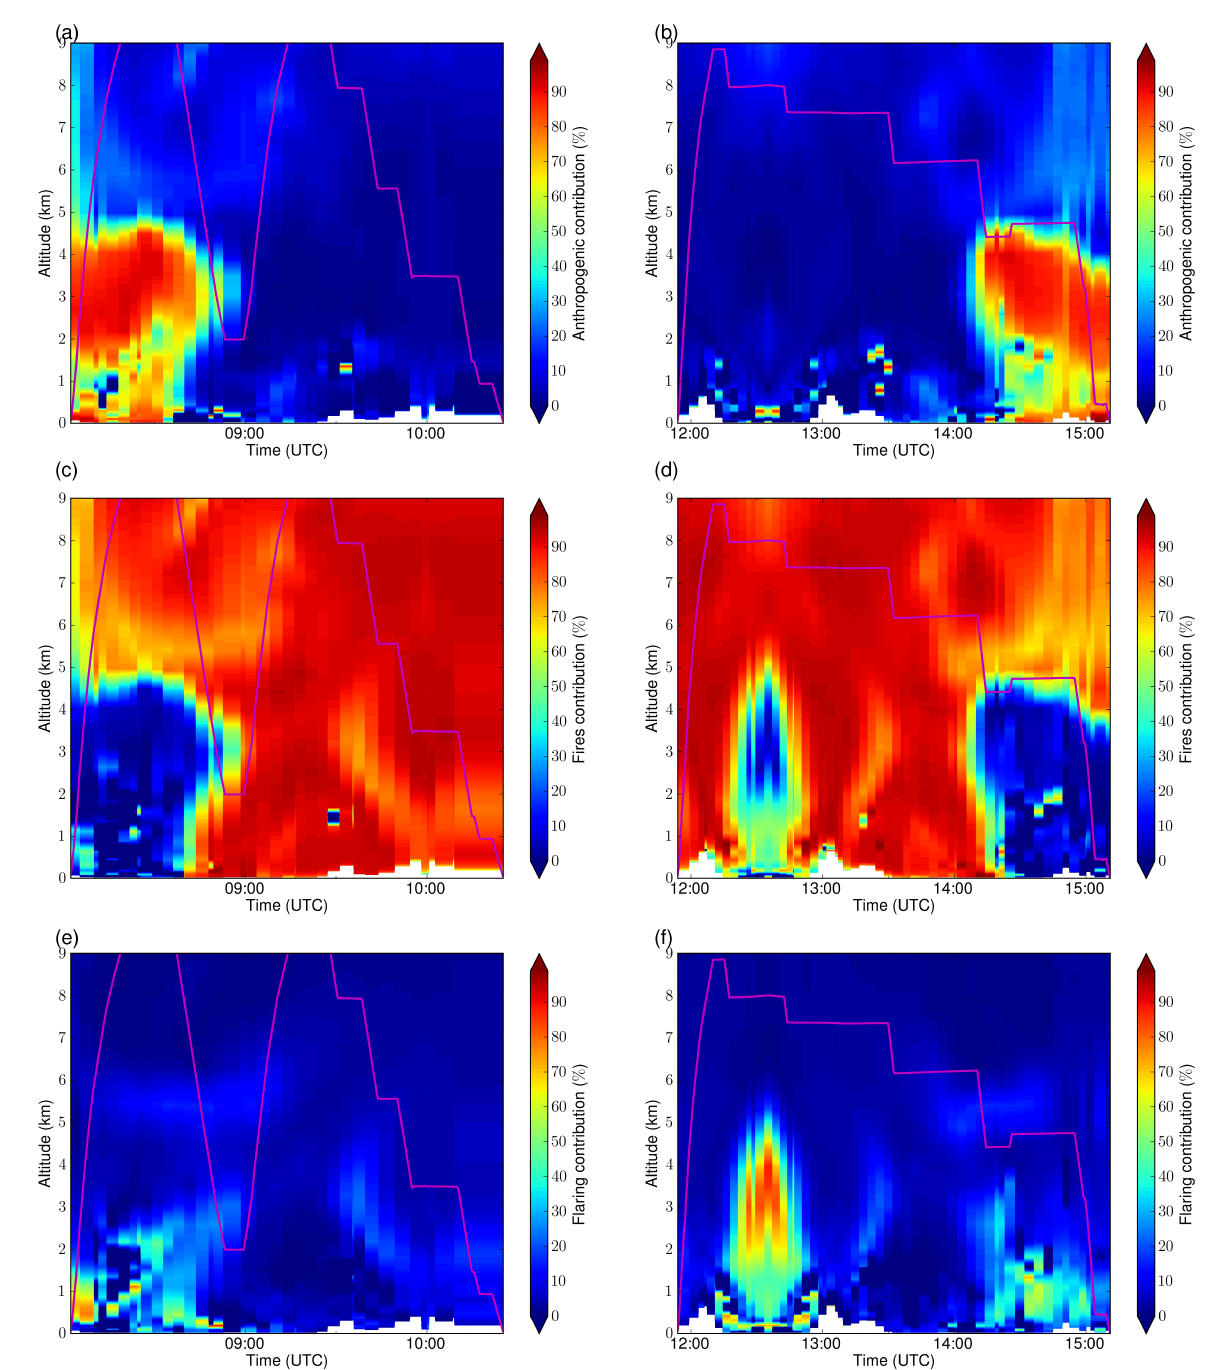
Figure 9. Time–altitude cross sections of the relative contributions (%) of BC concentrations due to (a, b) anthropogenic, (c, d) biomass burning and (e, f) flaring emissions along flight tracks 17a (in panels a , c and e ) and 17b (in panels b , d and f ). The altitude of the two flights is indicated in magenta in each